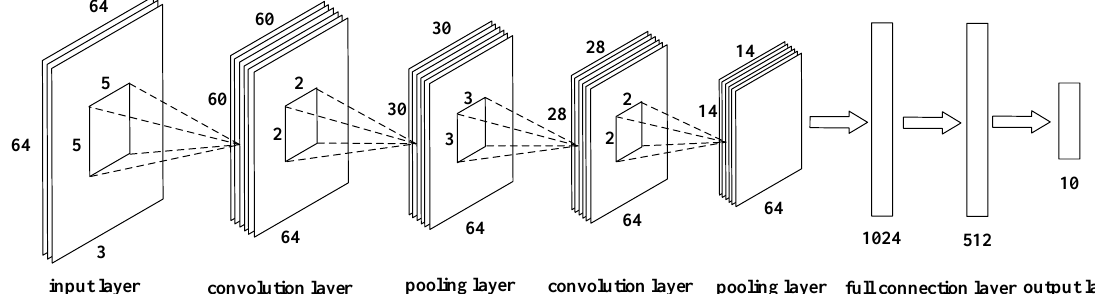
Figure 1. The structure of CNN